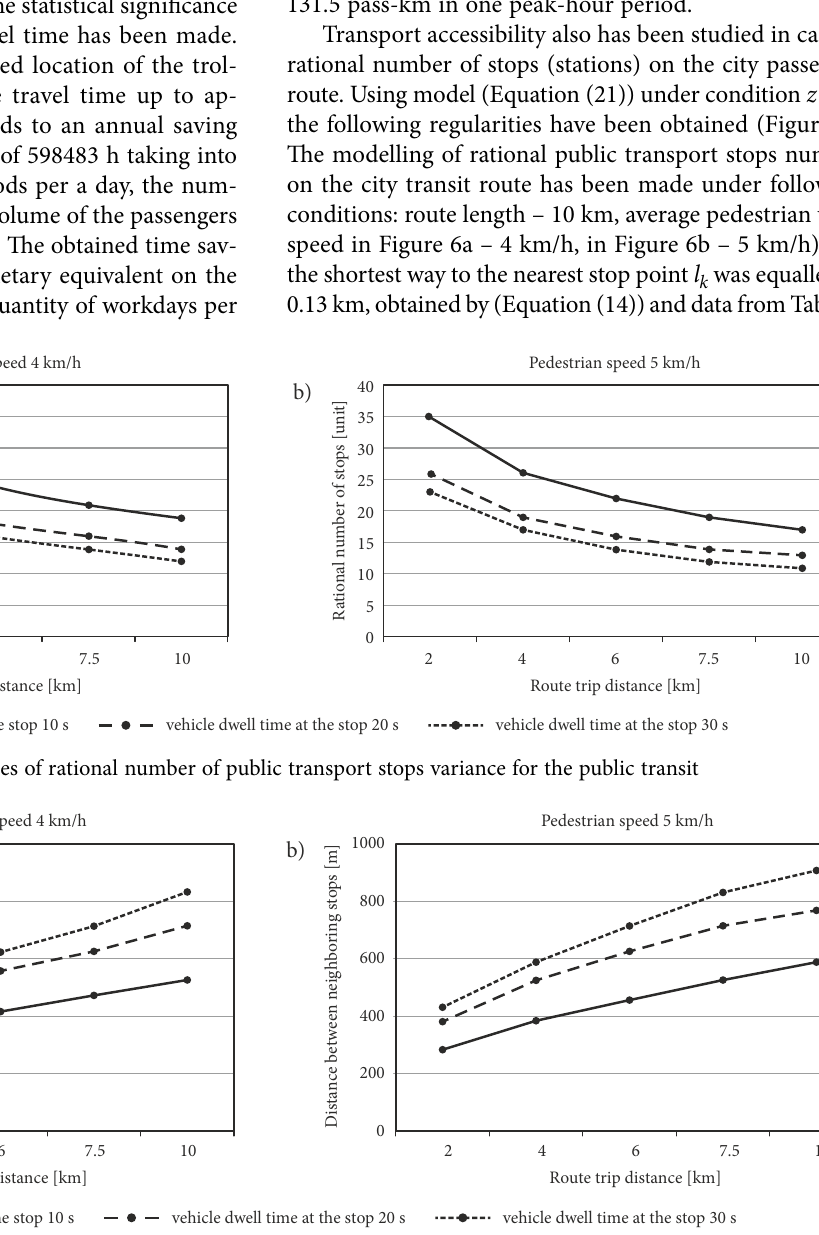
Figure 7. Regularities of distances between neighbouring stop points variance